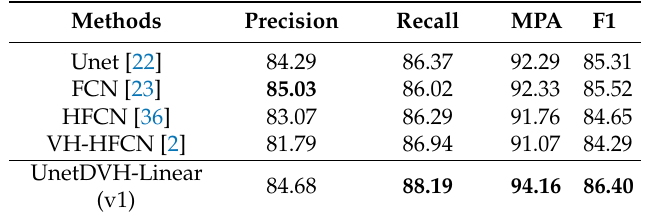
Table 3. Quantitative results of Parking slots segmentation performance on SS dataset